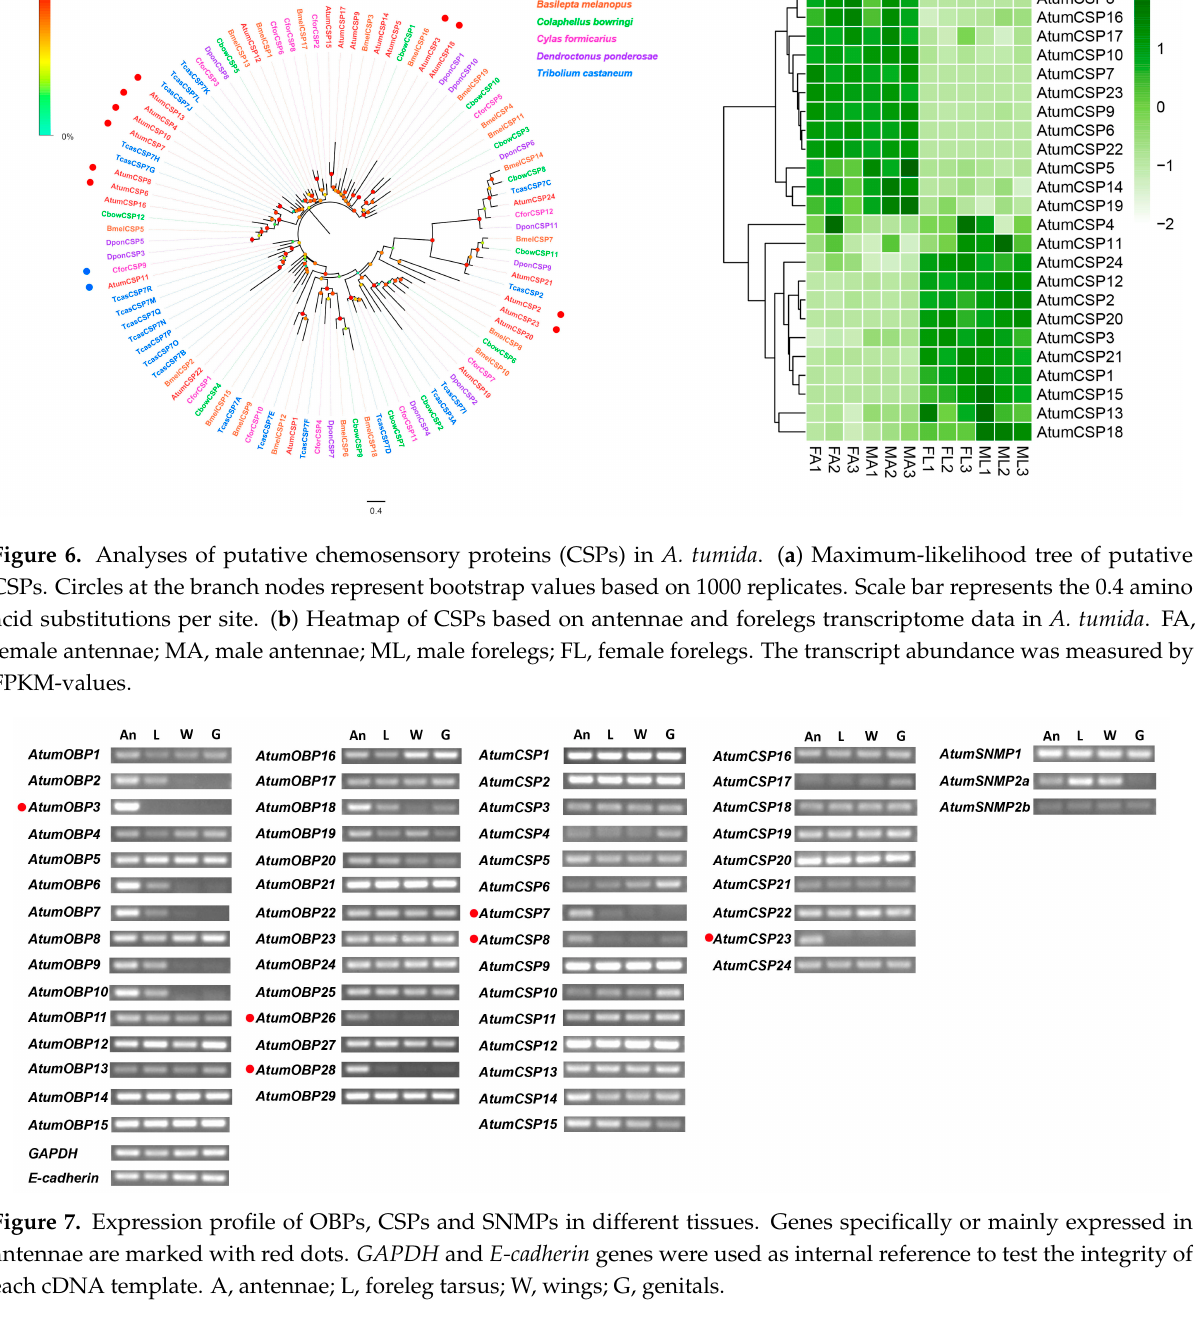
Figure 7. Expression profile of OBPs, CSPs and SNMPs in different tissues. Genes specifically or mainly expressed in antennae are marked with red dots. GAPDH and E-cadherin genes were used as internal reference to test the integrity of each cDNA template. A, antennae; L, foreleg tarsus; W, wings; G, genitals.